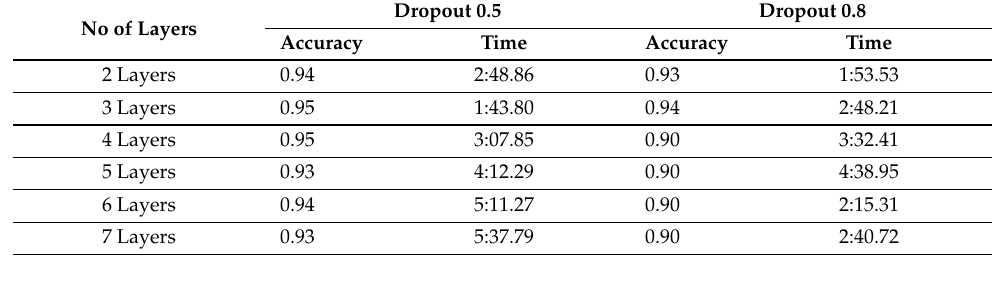
Table 9. Several architectures in evaluation using accuracy and time measures.